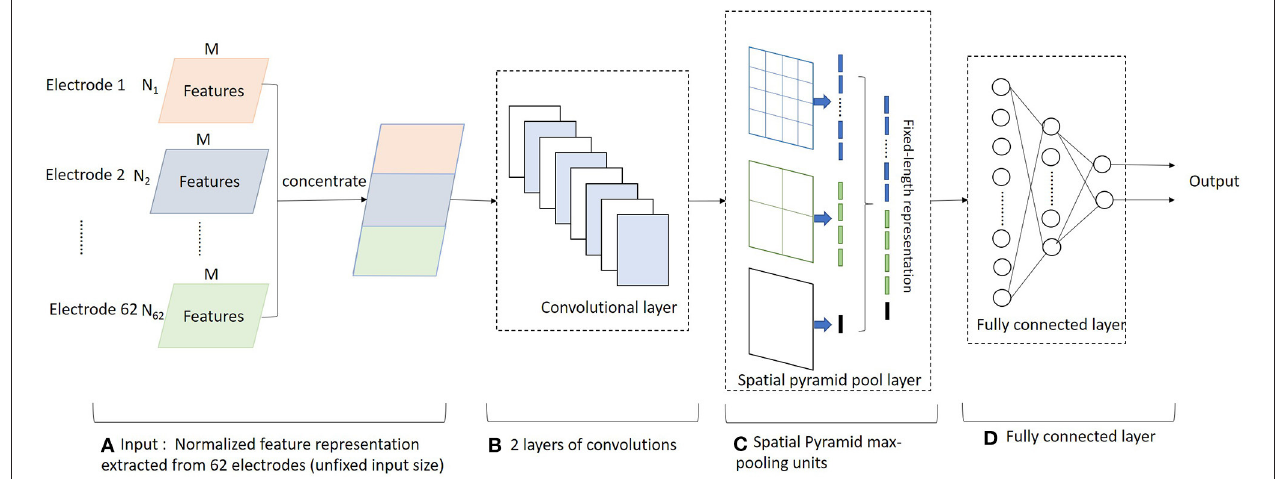
FIGURE 5 | The architecture of the SPP-net model. (A) Feature processing. (B) Convolutional layers. (C) Spatial pyramid pool layer. (D) Fully connected